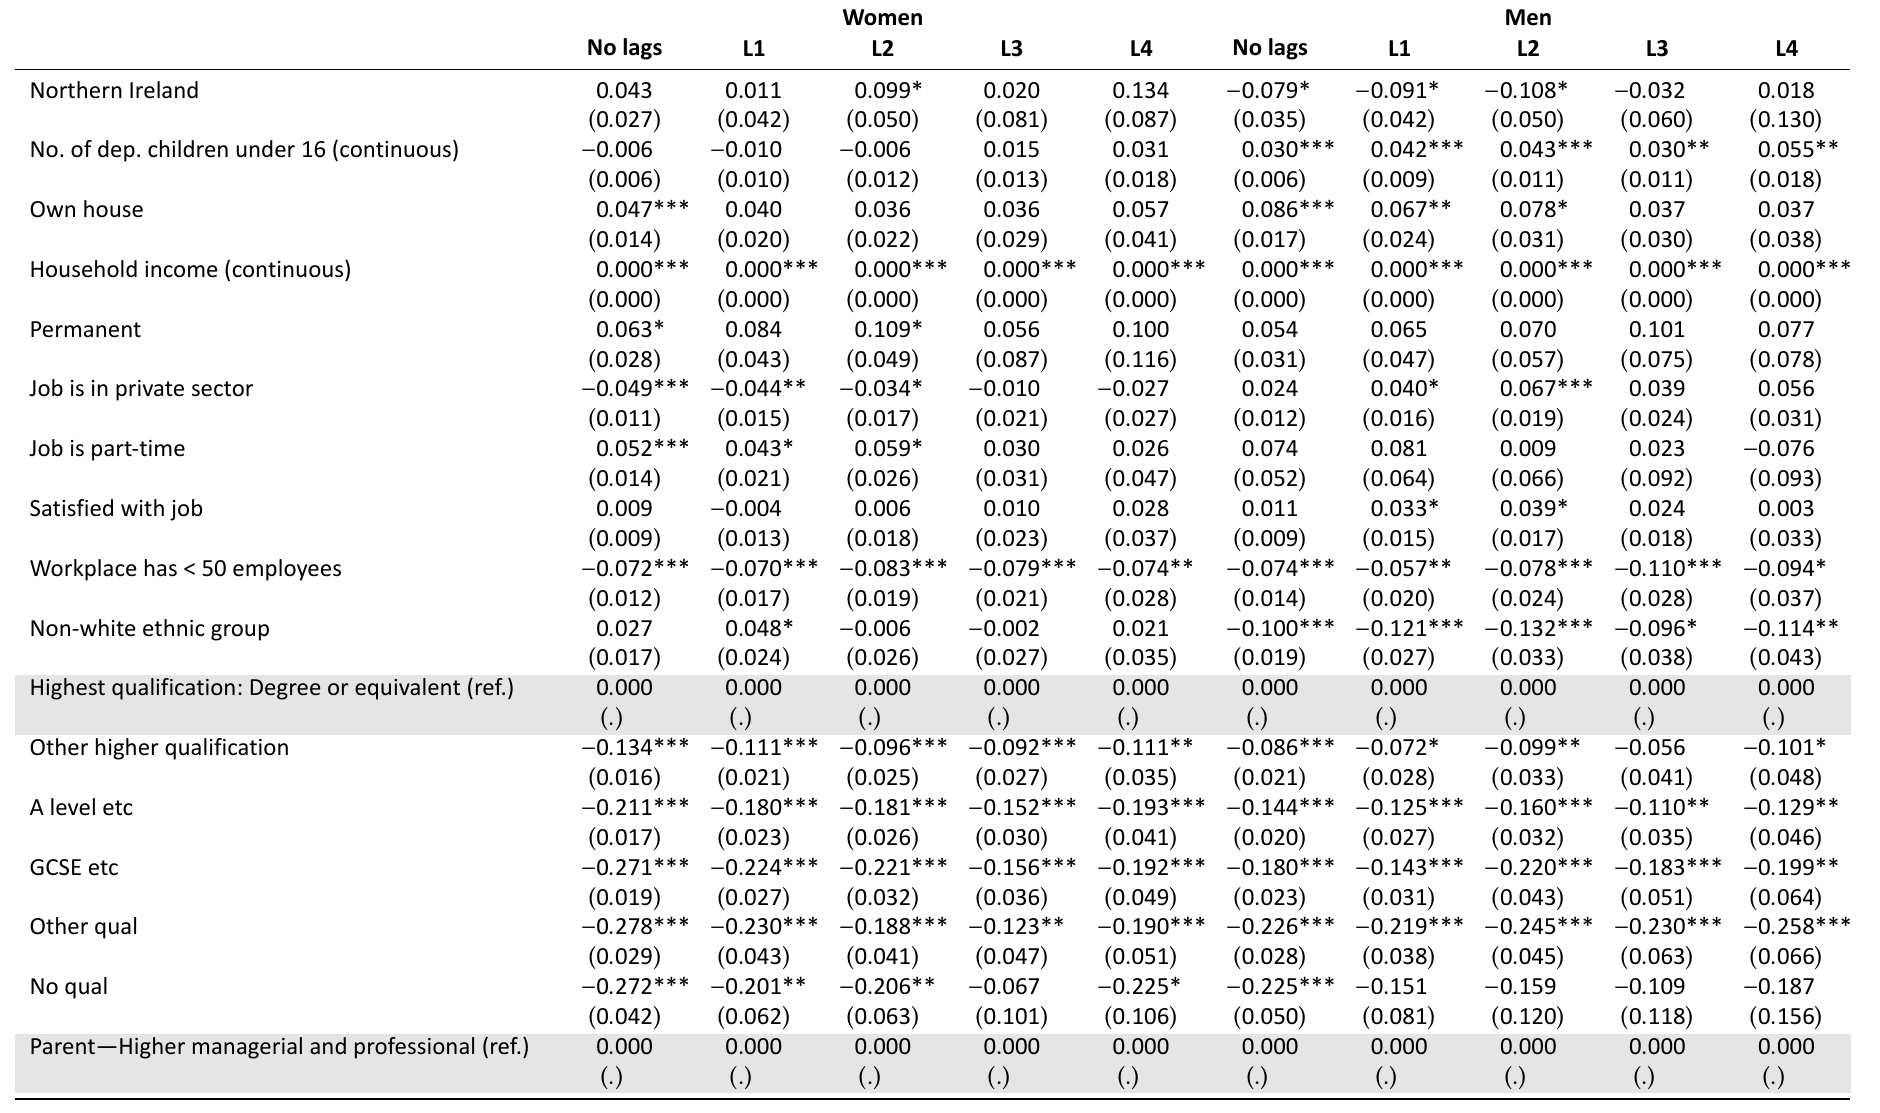
Table A5. (Cont.) Regression results, association between different reasons for participation in training and wages (log of hourly earnings), random